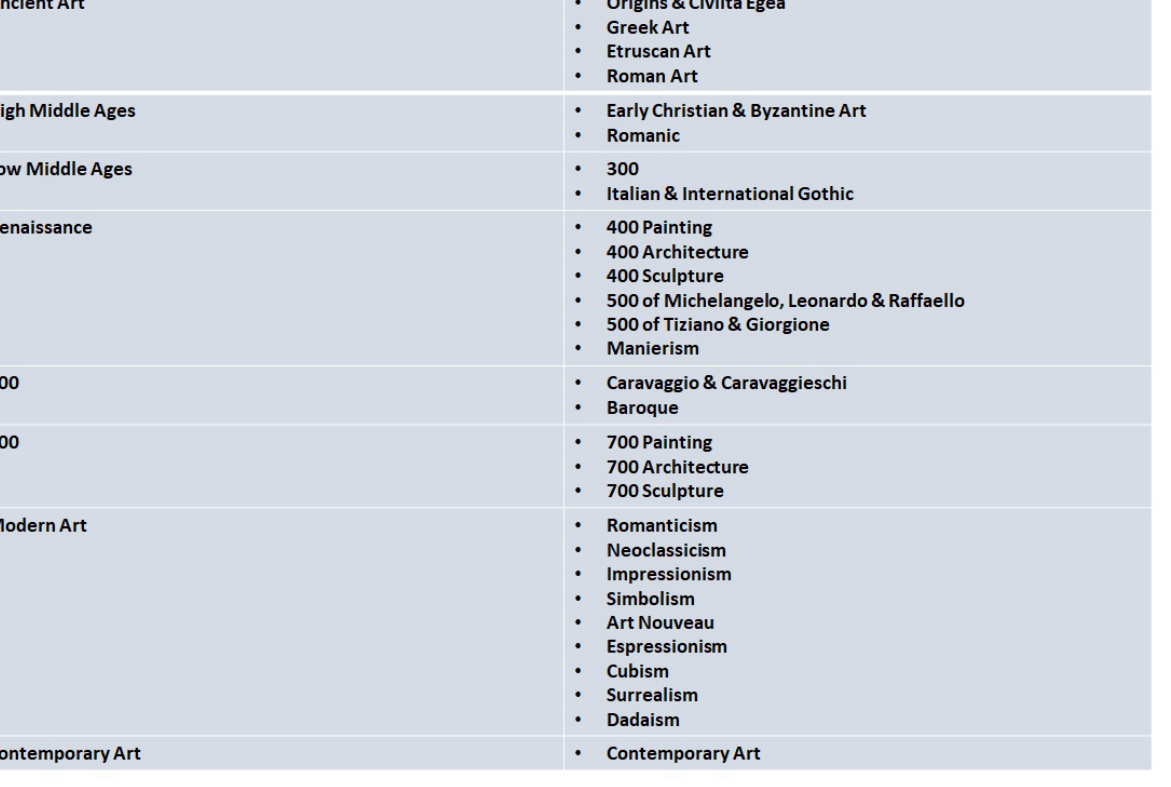
Figure 6. History of Art categorization exploited for designing the virtual